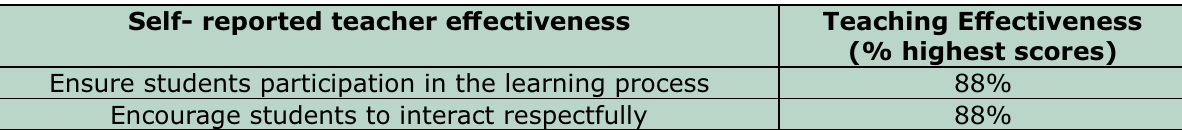
Table-III: Descriptive statistics for self-evaluated score of teaching effectiveness.